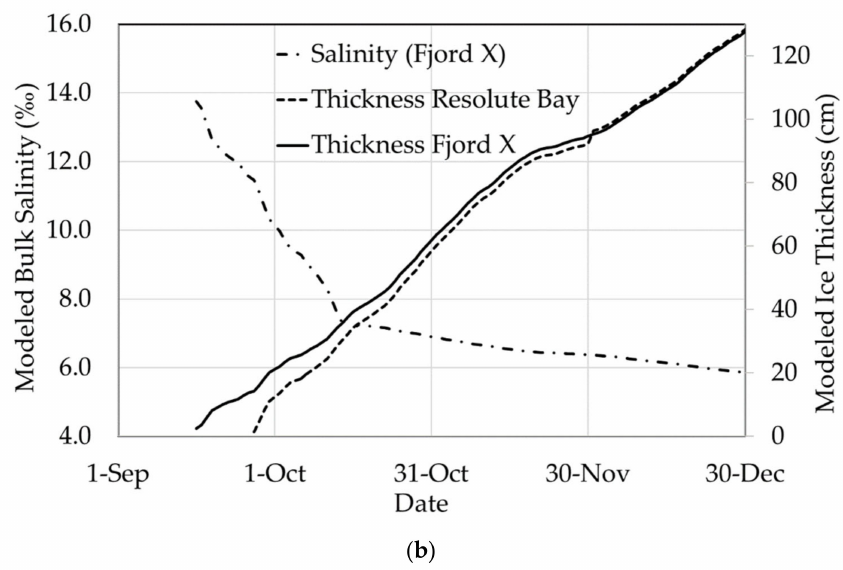
Figure 2. Temporal evolution of ( a ) the air temperature and ( b ) the estimated fast sea ice thickness in RB and FX and ice bulk salinity for